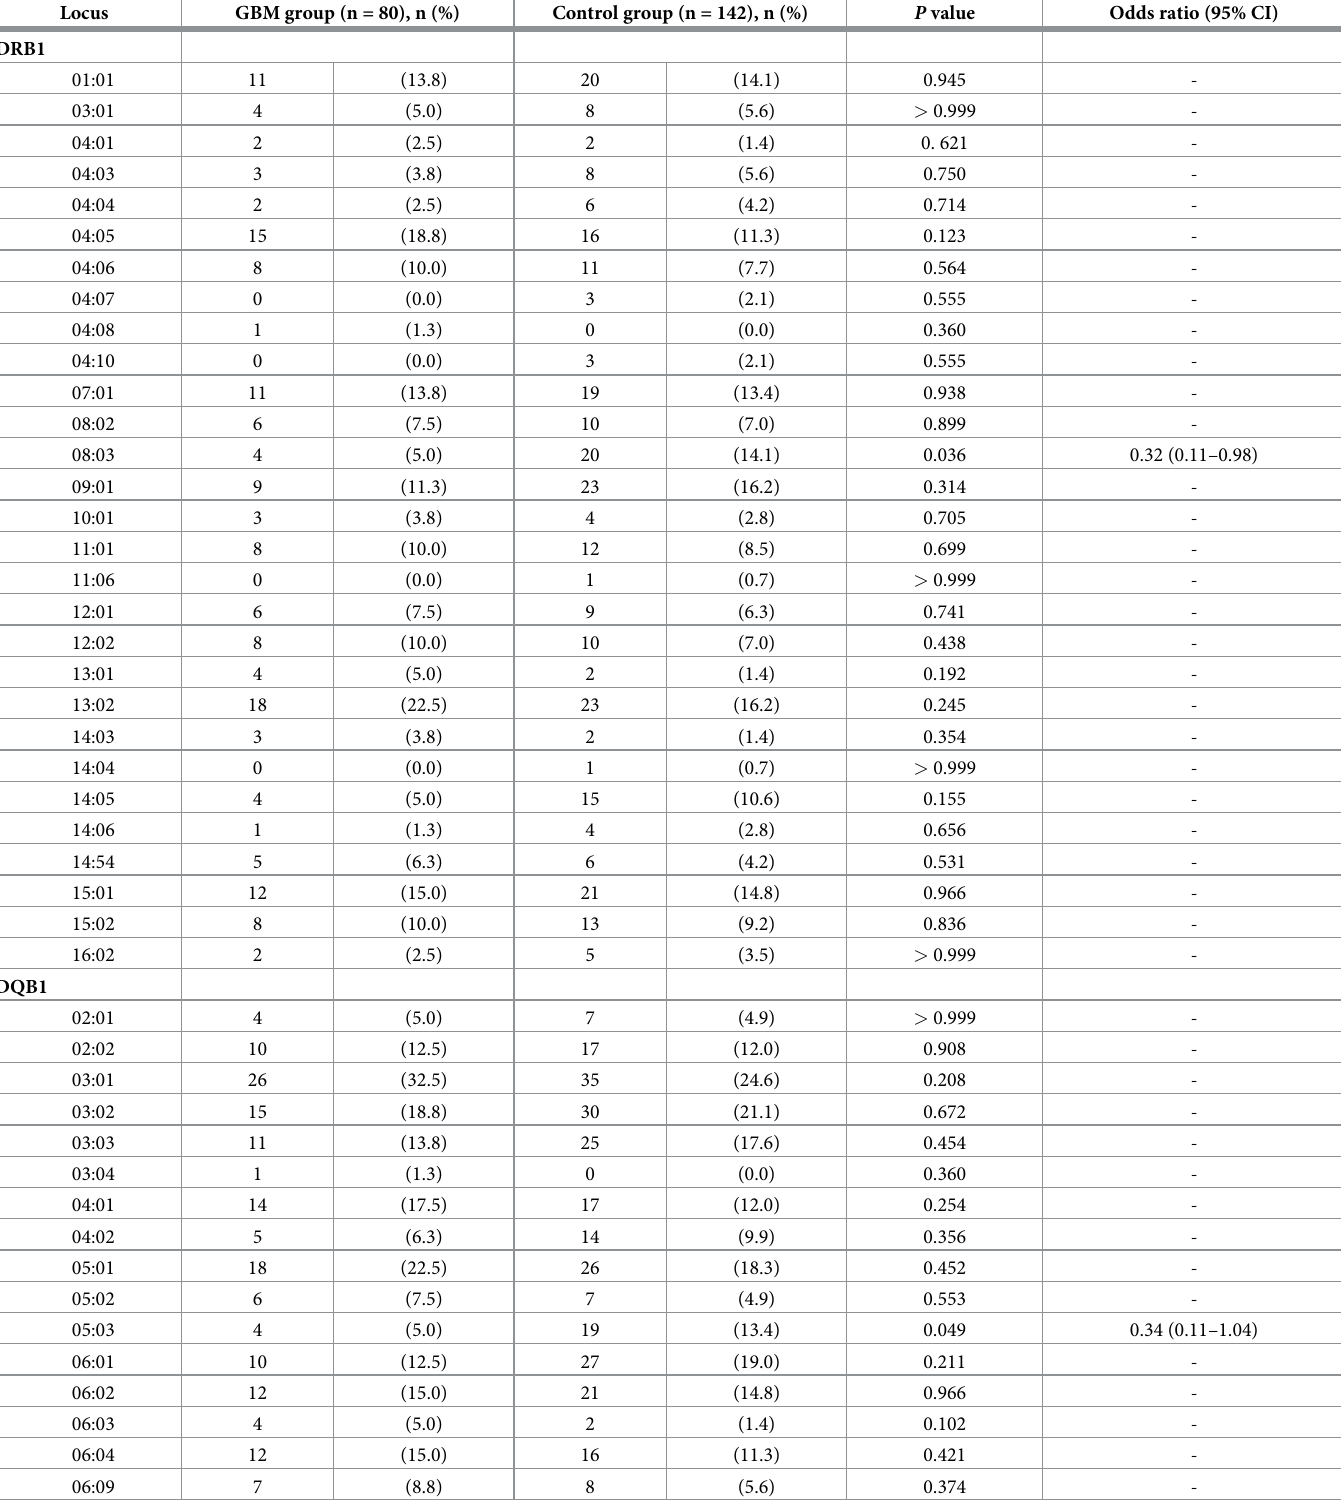
Table 3. HLA Class II allele frequencies in GBM and control groups.